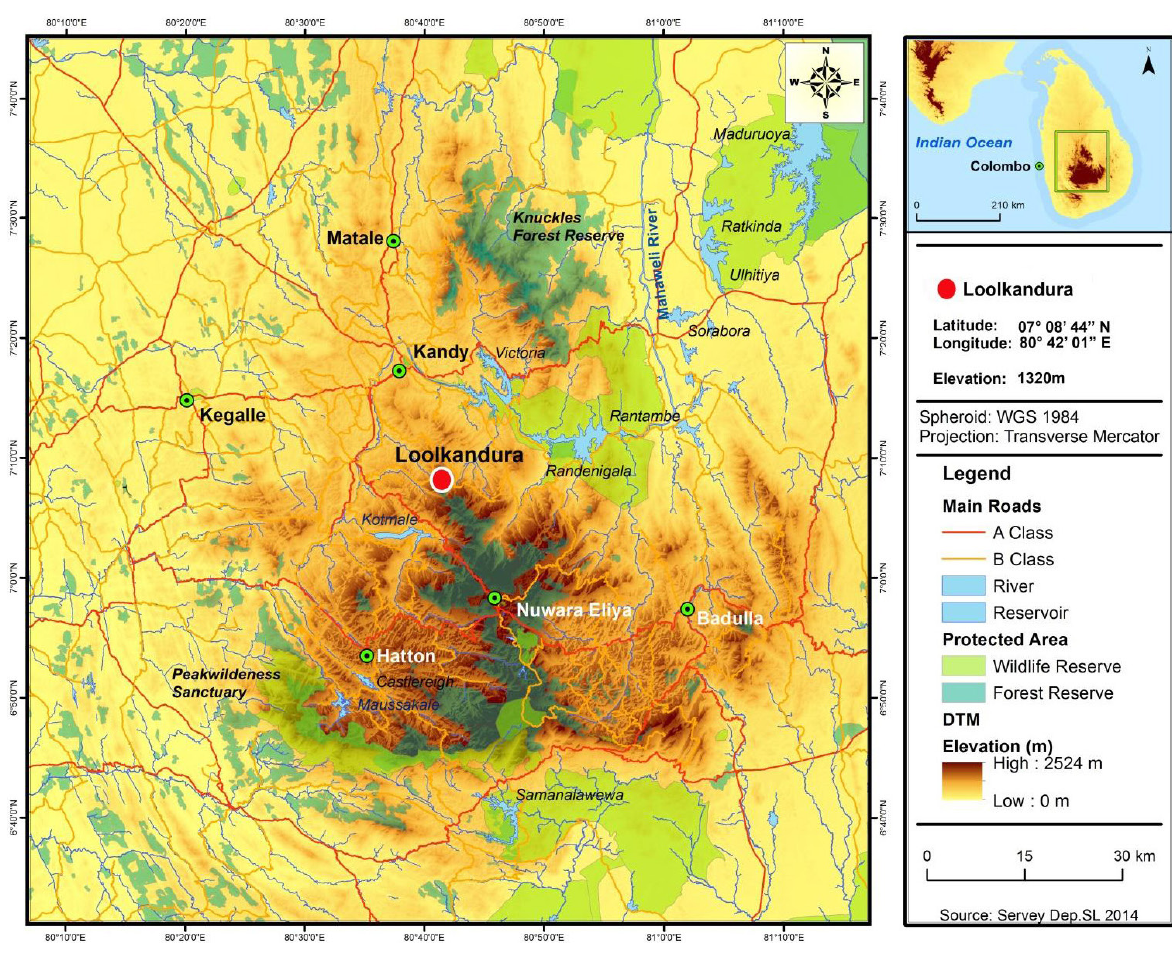
Figure 1. Type locality of Pseudophilautus dilmah sp.